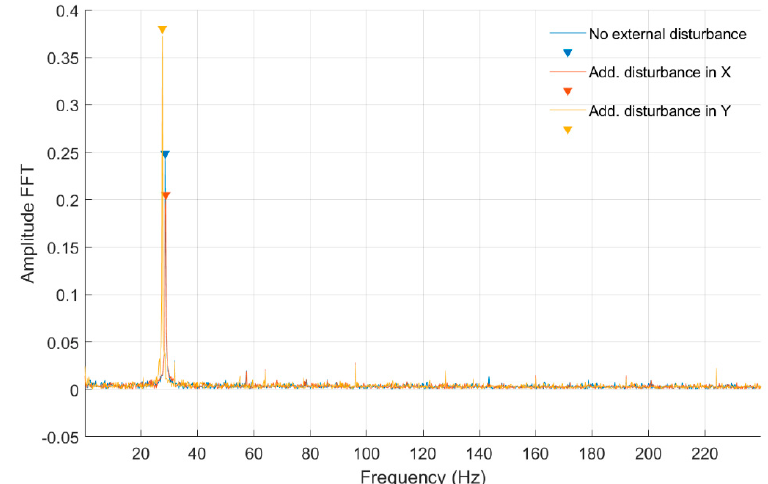
Figure 12. FFT of strain level measurement for constant motor speed equal to 30 rev/s with disturbance from the control system for a full-bridge configuration (Node 955).